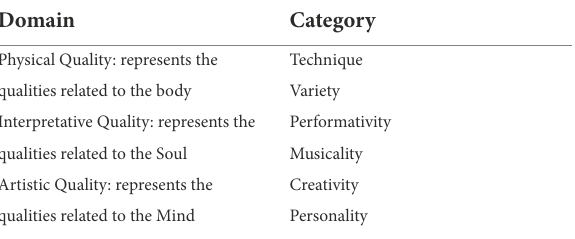
TABLE 2 Six categories used to evaluate hop-hop dance performance at the 2018 Youth Olympic Games.